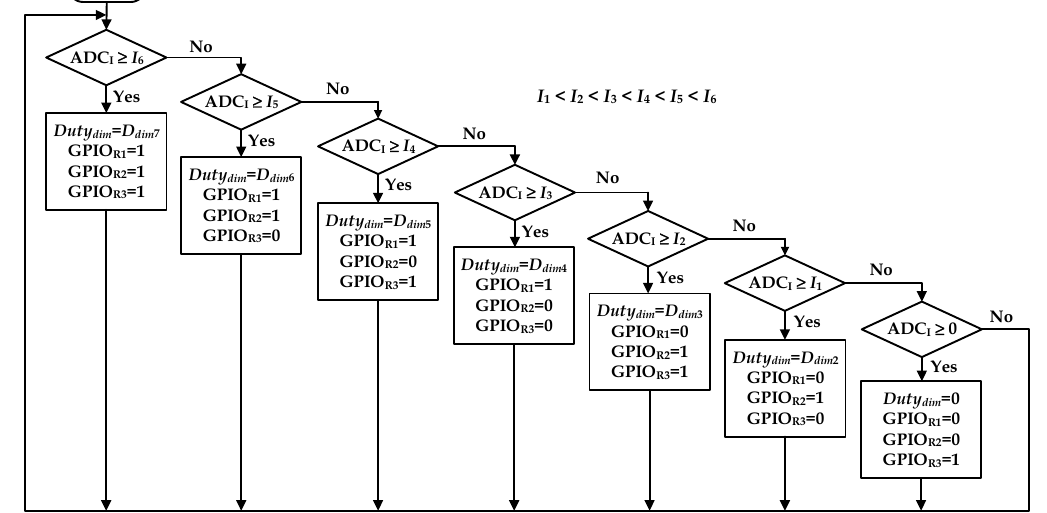
Figure 8. Control process of the dimming with VCSR.